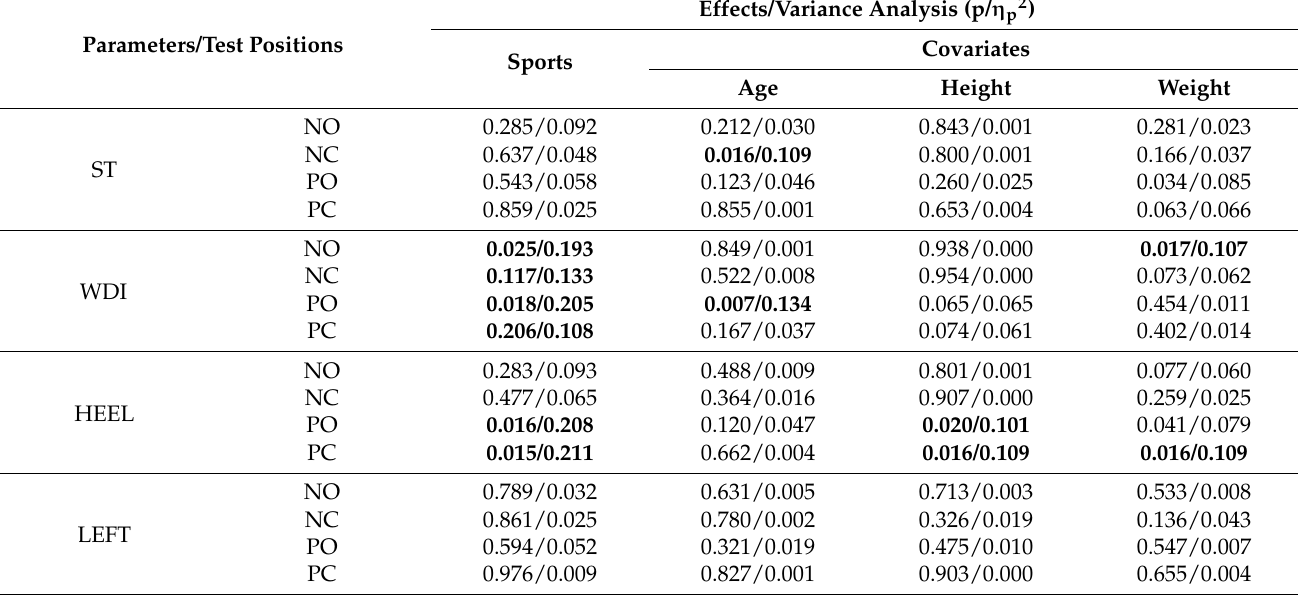
Table 2. Analysis of variance (covariates: age, weight, and height) between groups by test positions (eyes open, looking forward, and without foam pads (NO), eyes closed, looking forward, and without foam pads (NC), eyes open, head straight, and without foam pads (PO), and eyes closed, head straight, and foam pads (PC)) and parameters (stability indicator (ST), weight distribution index (WDI), heel, left). Meaningful differences ( η p2 > 0.10) between sports marked in bold.